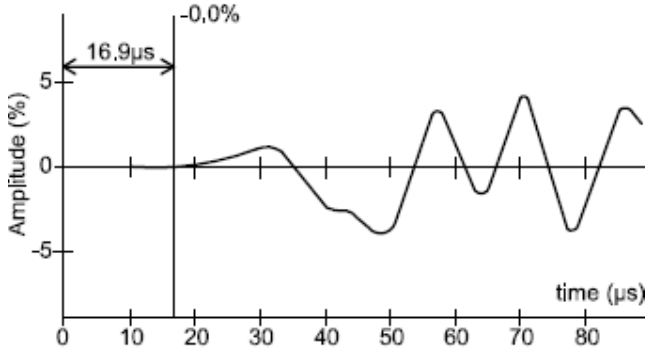
Figure 1. Ultrasonic pulse velocity time of flight: the off-set point on the amplitude–time curve.